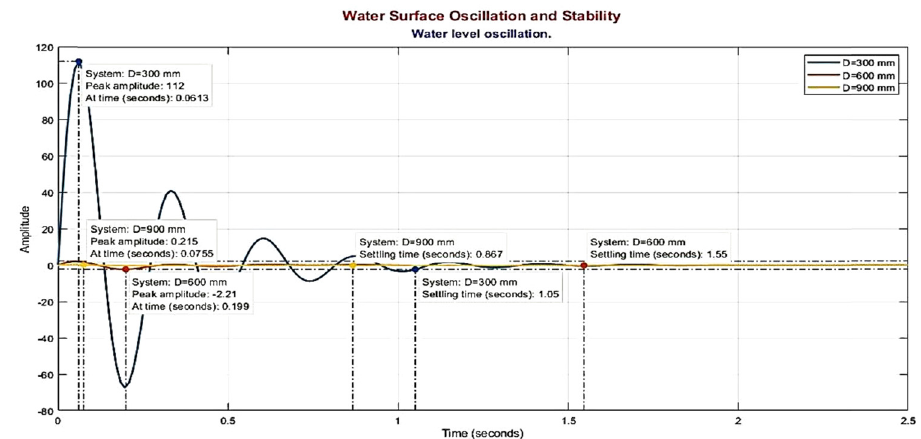
Figure 5: Stability of the system with di ff erent diameter e ff